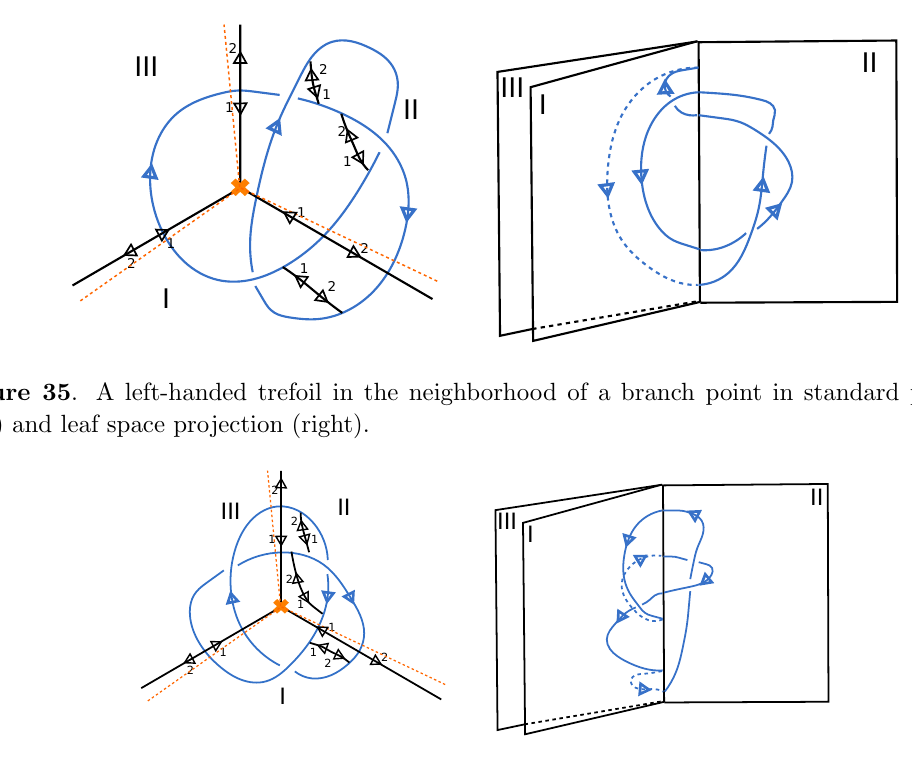
Figure 36 . Another left-handed trefoil in the neighborhood of a branch point in standard projection (left) and leaf space projection